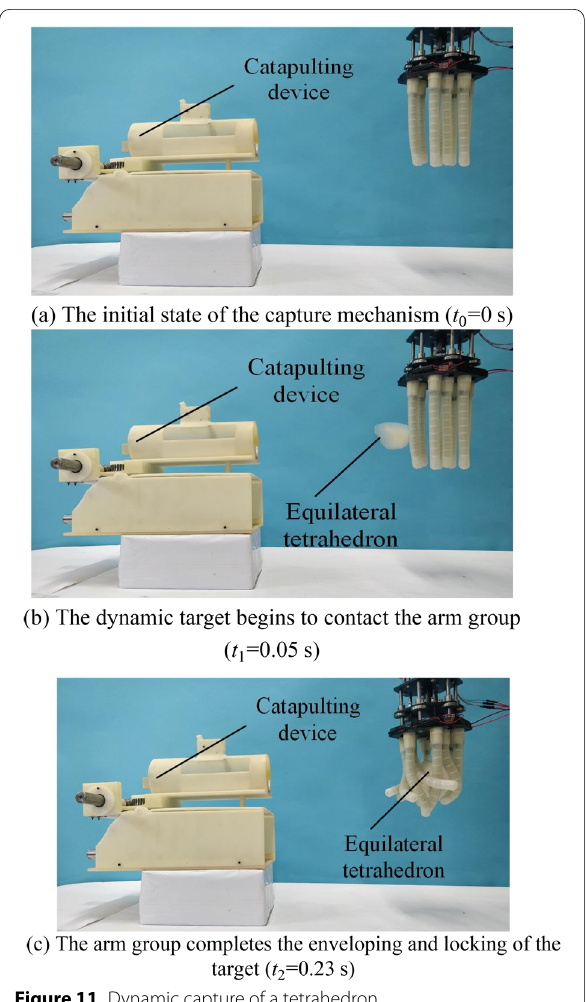
Figure 11 Dynamic capture of a tetrahedron